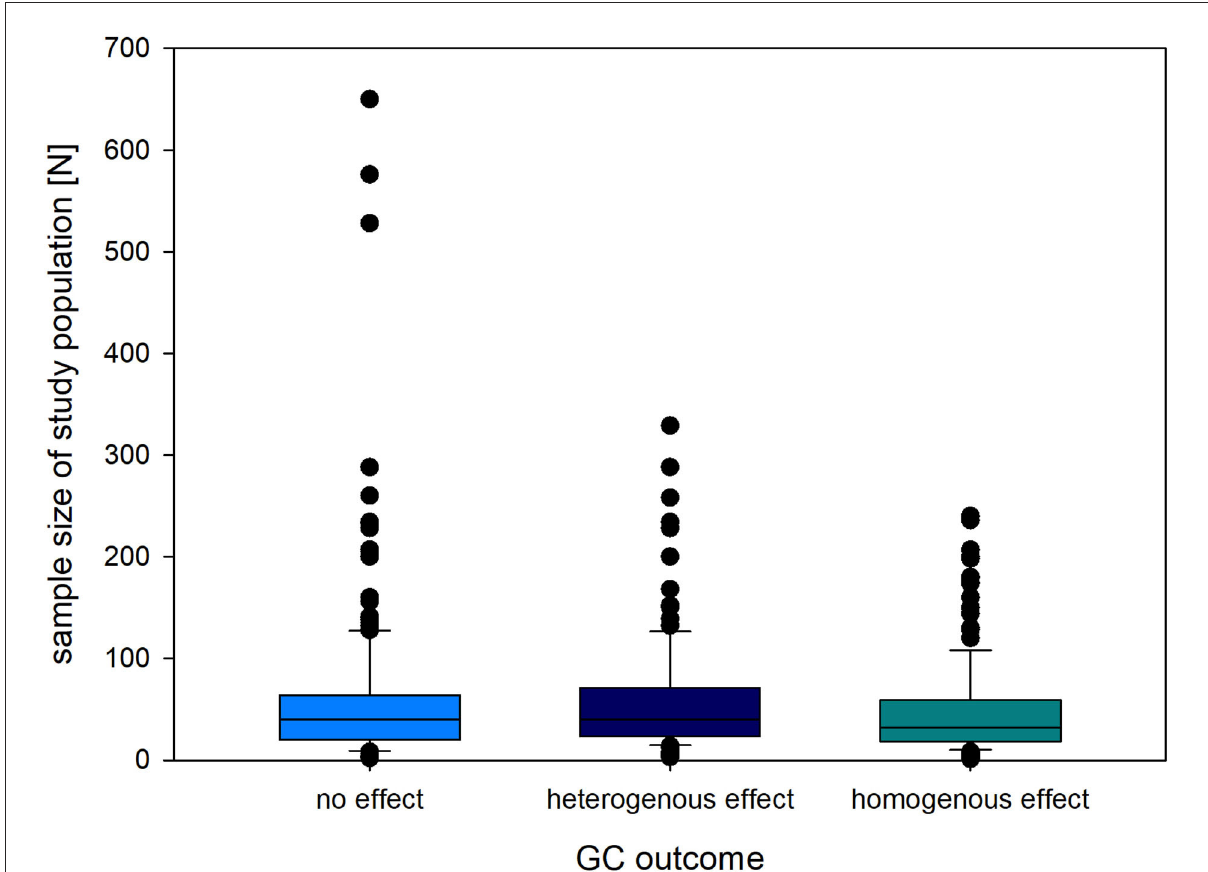
FIGURE4 Sample size ( N ) of animals sampled for GCs in studies finding a homogenous (consistent change in readout parameter compared to baseline/control), heterogenous (inconsistent change in readout parameter compared to baseline/control) or no effect of the intervention on GC levels. The box plots represent the median (and 10th, 25th, 75th and 90th percentile) as well as outliers (outside